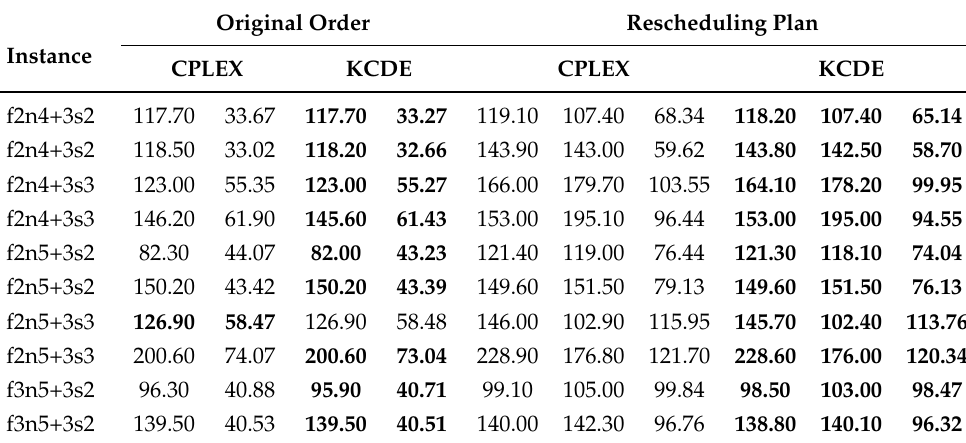
Table 1. Comparisons between CPLEX and